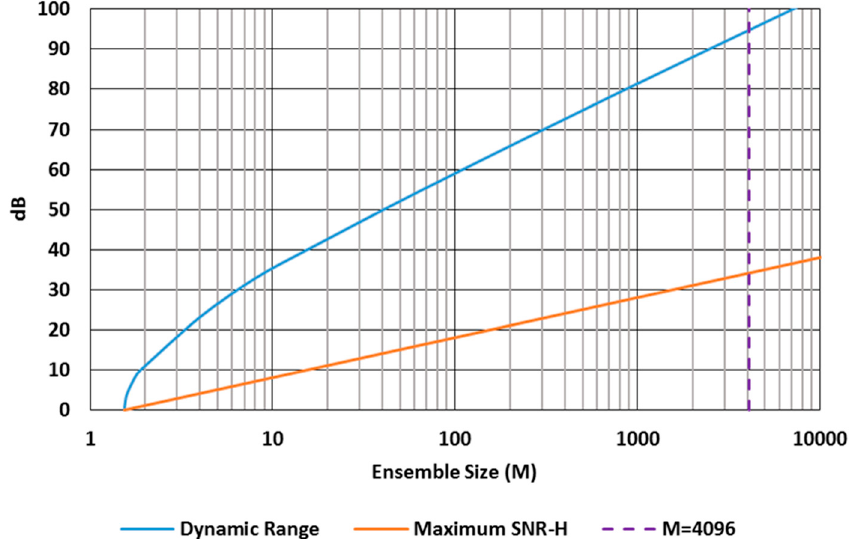
Figure 5. Single-bit QIS normal readout dynamic range (blue) and maximum SNR H as a function of ensemble or cubicle size M . For convenience, M = 4096 is highlighted by the purple dashed line. Note that M is confined to integer values despite the continuous nature of the curves in this figure.